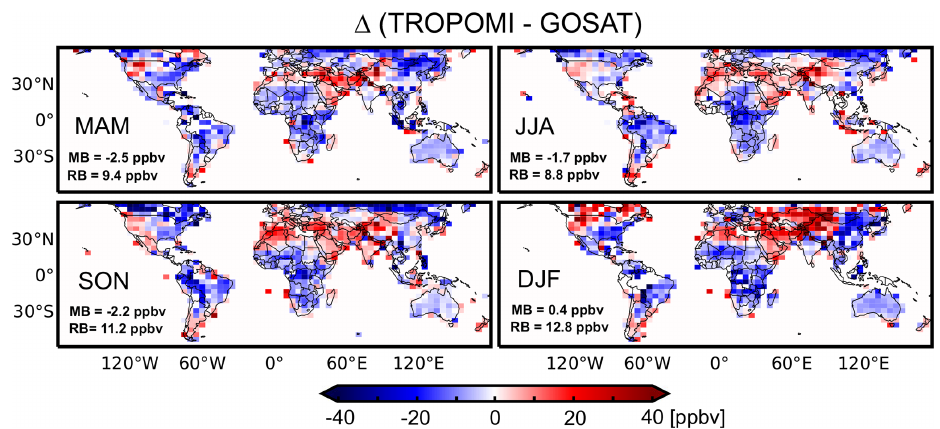
Figure 3. Seasonally averaged differences ( (cid:49) ) of X CH between TROPOMI and GOSAT retrievals for May 2018–April 2019 on a 4 ◦ × 5 ◦ 4 grid. The retrievals have been corrected for differences in averaging kernels and prior vertical profiles as described in the text. MB is the global mean bias of TROPOMI relative to GOSAT, and RB is the regional bias as defined by the standard deviation of (cid:49) on the 4 ◦ × 5 ◦